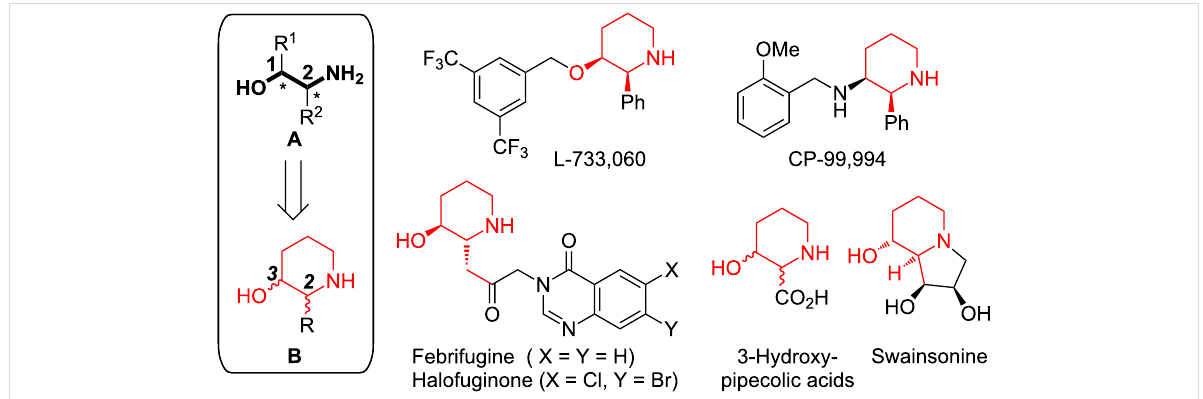
Figure 1: Natural products and other bioactive piperidine derivatives of type B